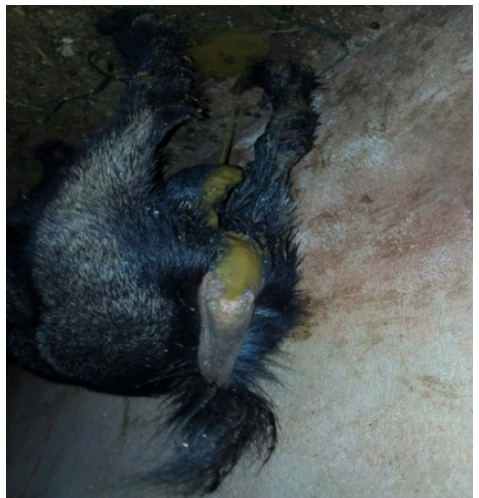
Fig. 2 Perineal region of a WAD goat suffering from PPR showing profuse watery diarrhoea